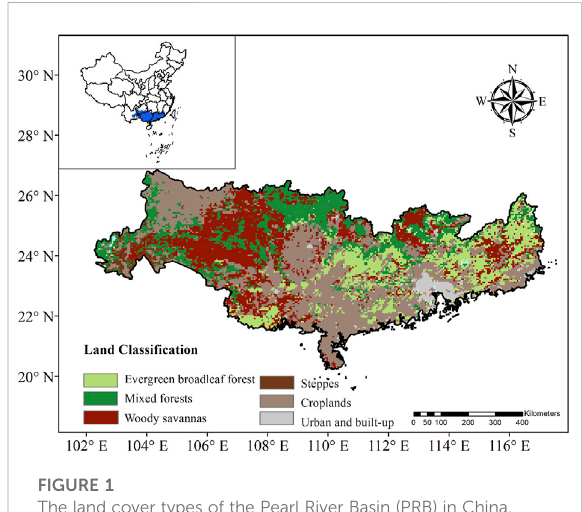
FIGURE 1 The land cover types of the Pearl River Basin (PRB) in